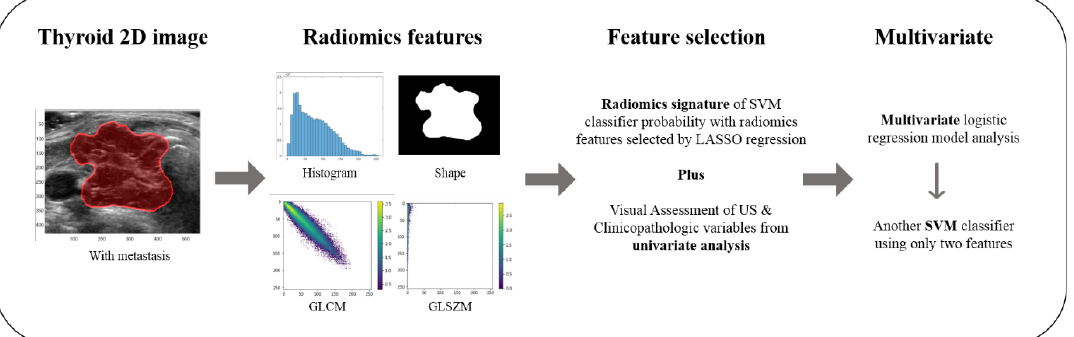
Figure 1. The study process: The most representative image of each tumor on thyroid 2D ultrasound (US) image was selected. Radiomics features including first order, shape, gray-level cooccurrence matrix (GLCM), and gray-level size zone matrix features (GLSZM) were extracted. A radiomics signature was generated using the least absolute shrinkage and selection operator (LASSO) and was used to train a support vector machine (SVM) classifier in five-fold cross-validation. For determining association between the radiomics signature, US findings, clinicopathological variables, and distant metastasis, univariate and multivariate logistic regression analyses were performed. Another SVM classifier was built using significant variables from the multivariate analysis.